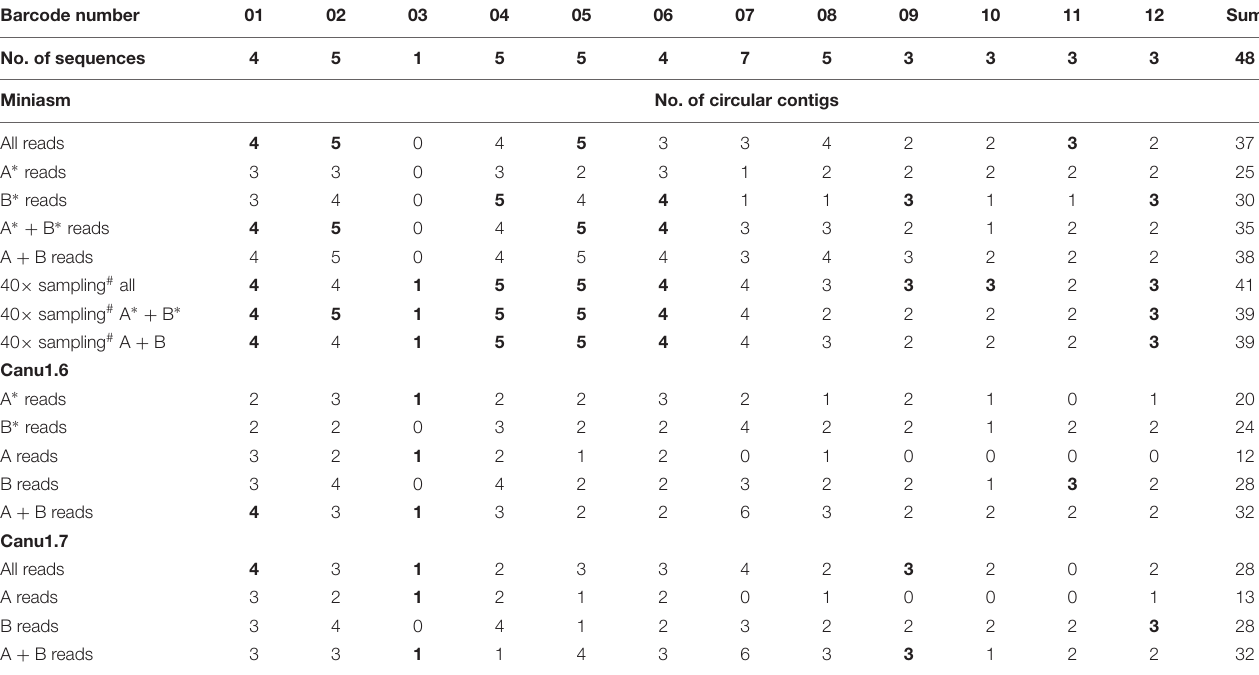
TABLE 3 | Number of circular contigs produced by miniasm and Canu with different subsets of reads. Barcode